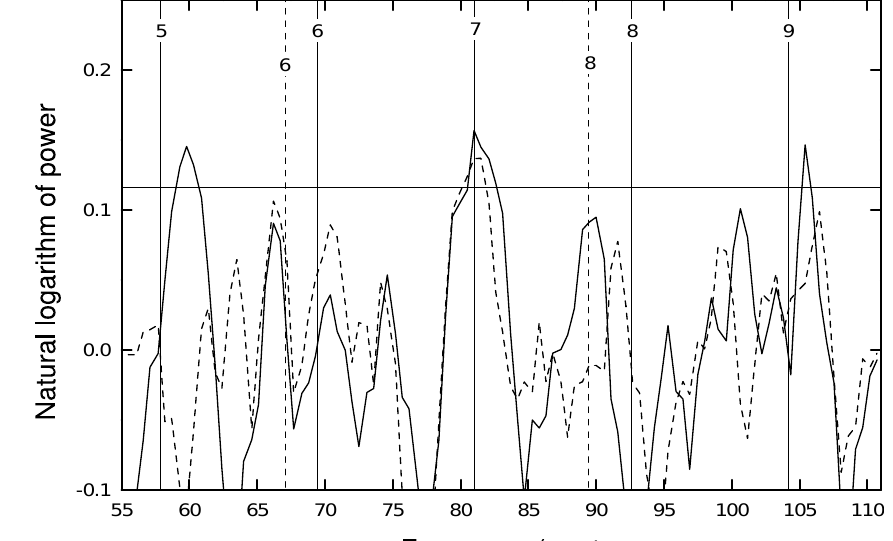
Fig. 2. As for Fig. 1 but for the 2.5 − 5-h period